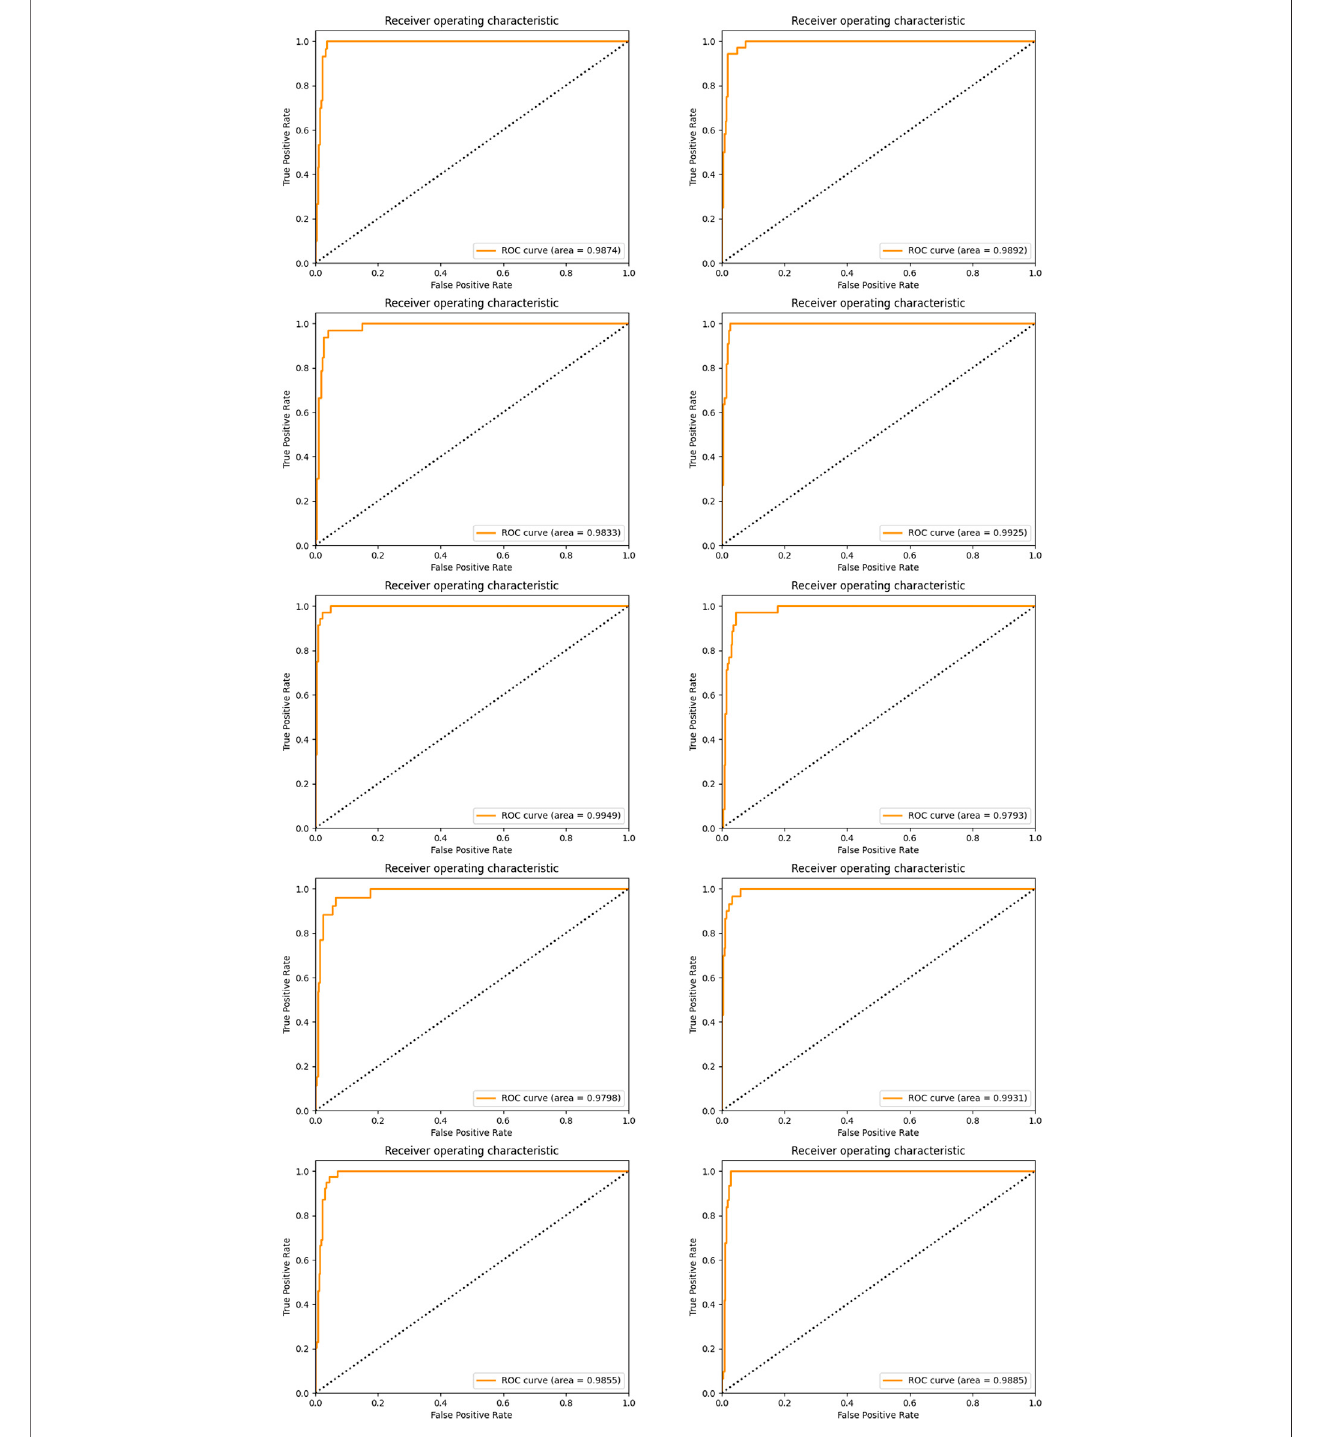
FIGURE 6 | ROC curves and the corresponding AUCs of a fi ve-miRNA signature after ten-time sample division.